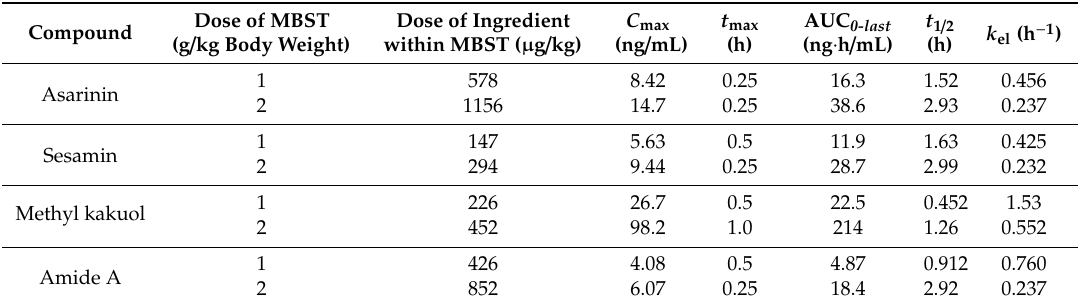
Table 2. Pharmacokinetic parameters of Asiasari Radix ingredients measured in maobushisaishinto (MBST)-treated rat